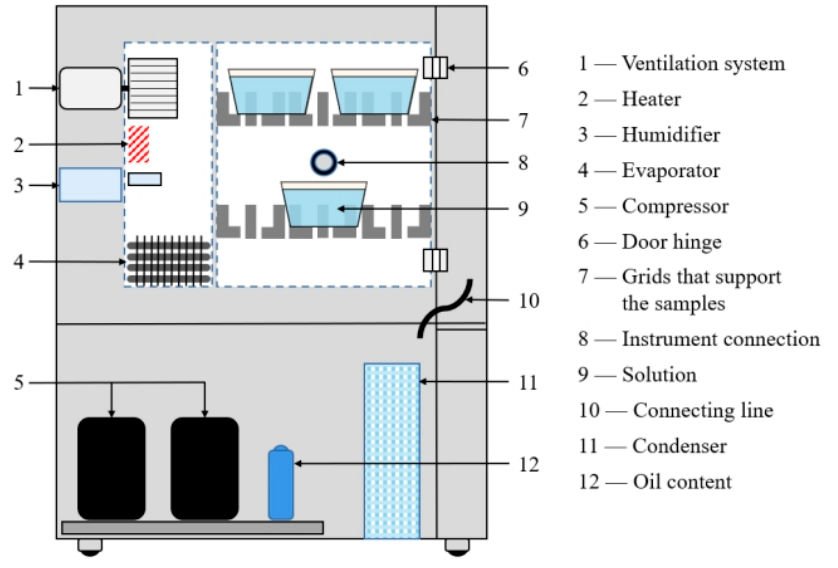
Figure 5. Environmental cabinet principle model.